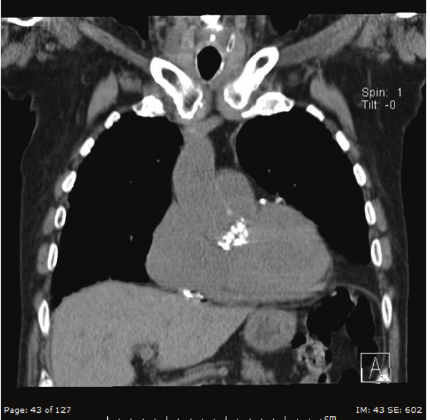
Figure 3: Coronal section of CT chest showing heavily calcified aortic